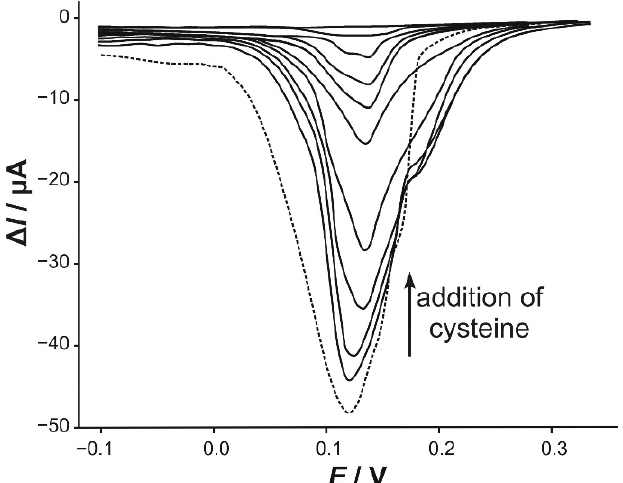
Figure 5. Differential pulse voltammograms, recorded at the CPE modified with 5% of the material, in acetate buffer at pH 5, upon successive addition of cysteine for obtaining: 0.1, 0.4, 0.9, 1.6, 2.6, 5.6, 10, 17, 27, 57, 100 and 170 μ M in an acetate buffer solution (pH 5). The dashed line represents DPV recorded without cysteine solution. Initial measurement parameters: conditional potential 25 mV, pulse amplitude 0.05 V, pulse width 0.05 s, step potential 0.01 V.